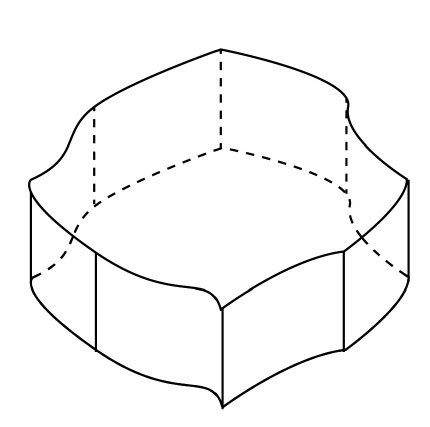
Figure 10. Outline of the model behavior in three dimensions.